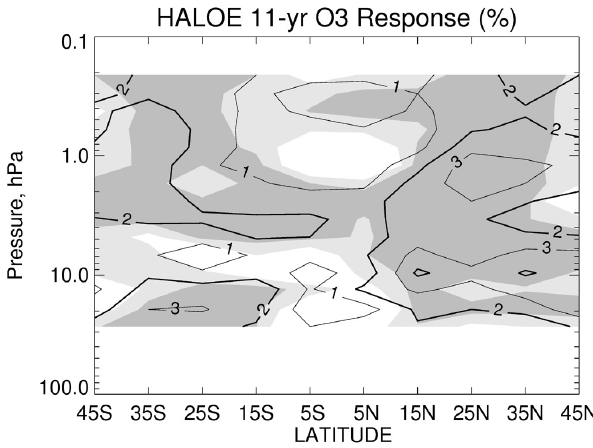
Fig. 12. As in Fig. 6, but for the HALOE max minus min, 11- yr responses in ozone. Darker shading denotes where CI > 90%; lighter shading denotes 70% < CI < 90%.